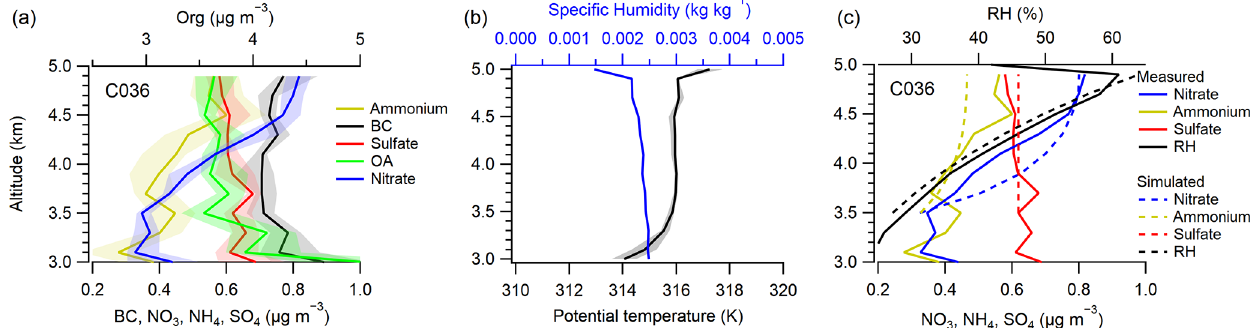
Figure 10. The vertical distributions (3000–5000m) of (a) different chemical composition concentrations and (b) potential temperature and specific humidity in flight C036 (24 August). The lines and shades represent the 25th percentile, median and 75th percentile in every 200m bin. (c) The simulated and measured chemical composition and RH at different altitudes with variable